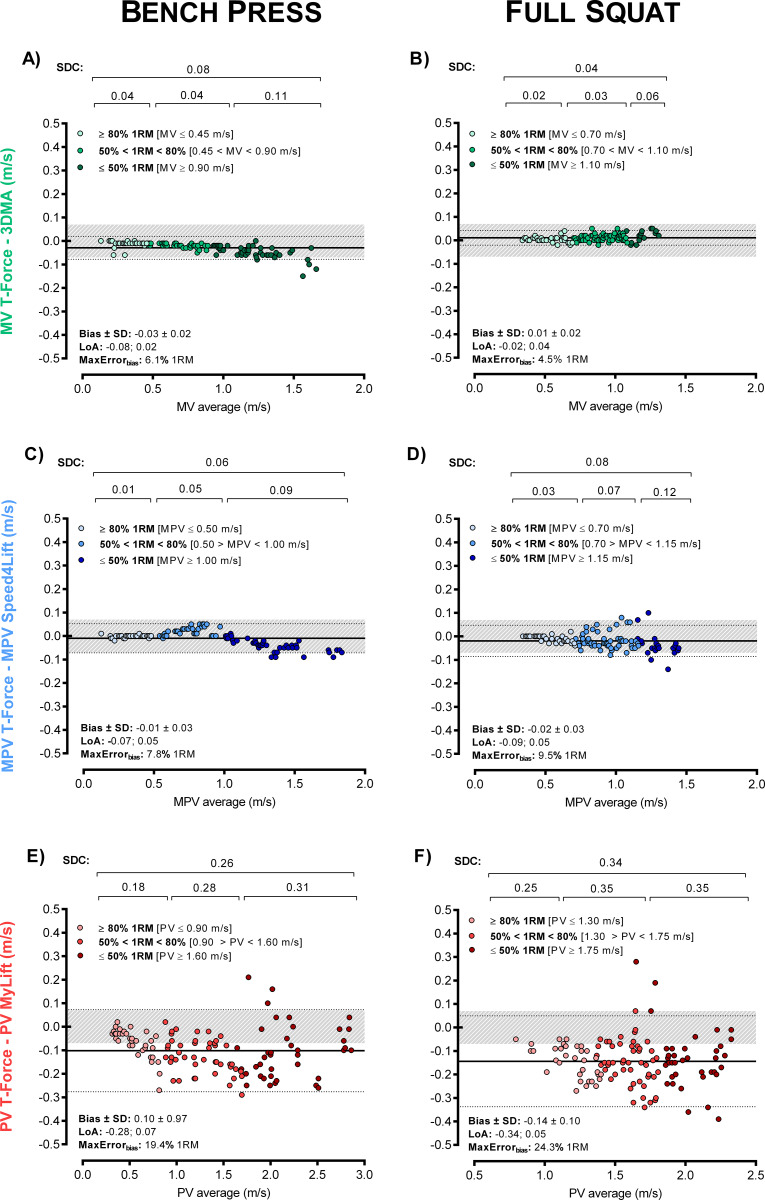
Bland-Altman plots for the inter-device agreement in bench press (BP) and full squat (SQ).Each technology is presented in a different colour and compared against the reference. The grey shaded area indicates an acceptable level of agreement between devices, which results in differences in terms of load ≤ 5% 1RM [26,27].